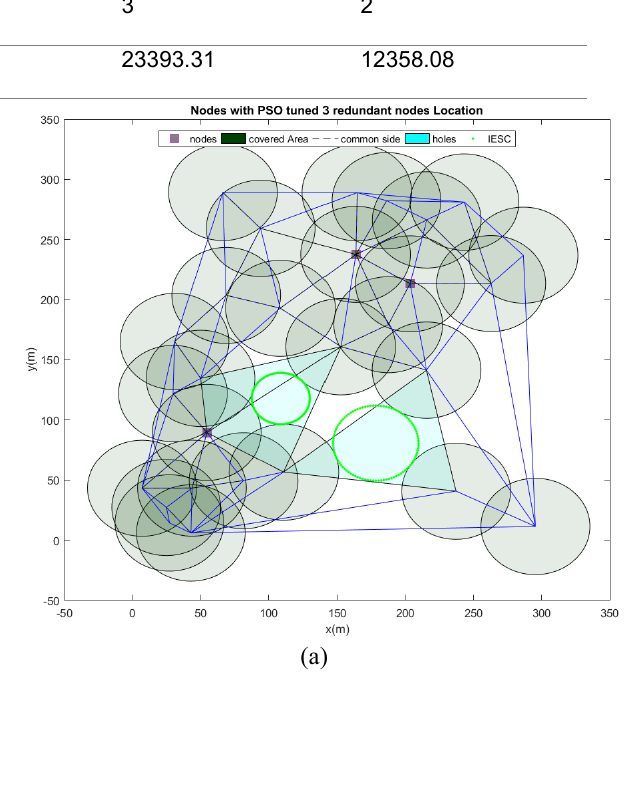
Table 2. Comparative analysis of detected coverage holes and coverage area after hole mitigation Without healing